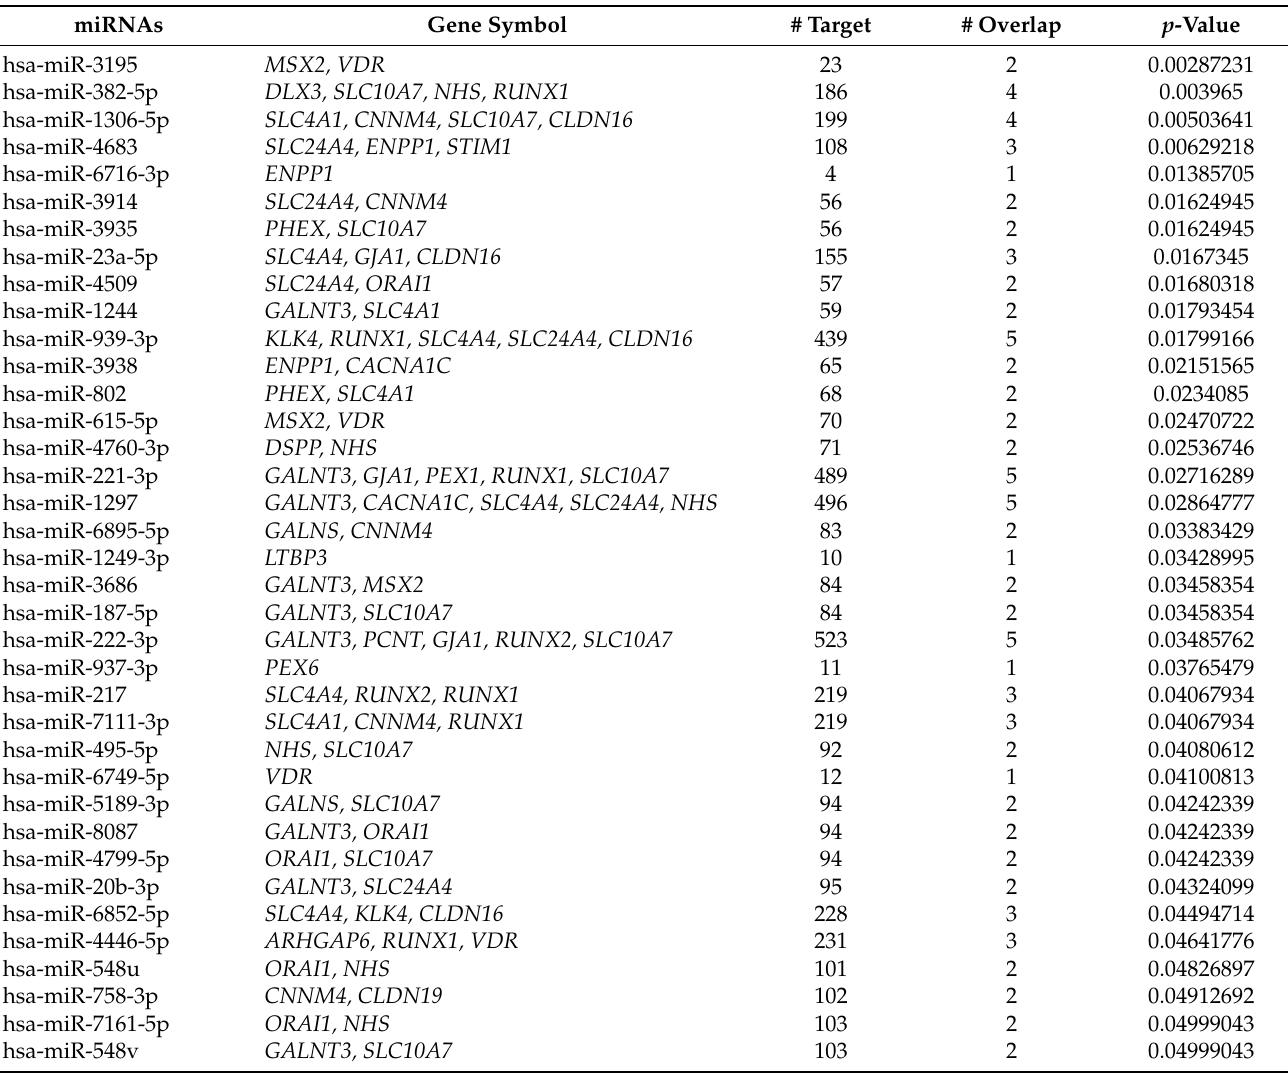
Table 4. MicroRNA (miRNA) enrichment analysis of amelogenesis imperfecta-associated genes.